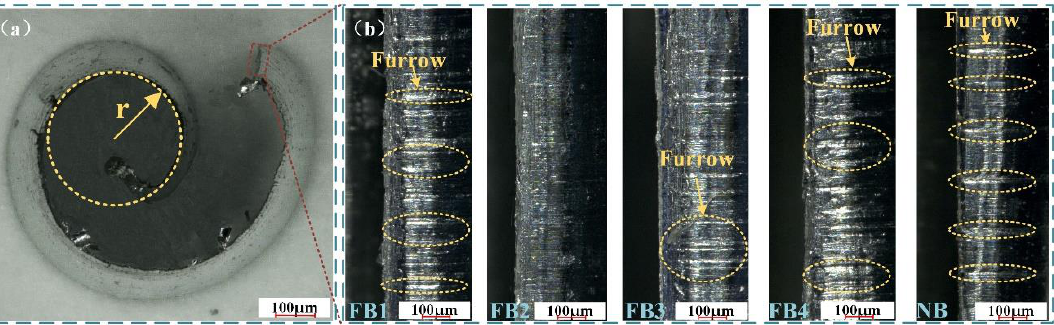
Figure 12. ( a ) Morphology of chip curl; ( b ) The end of chip morphology by different broach surfaces at 40